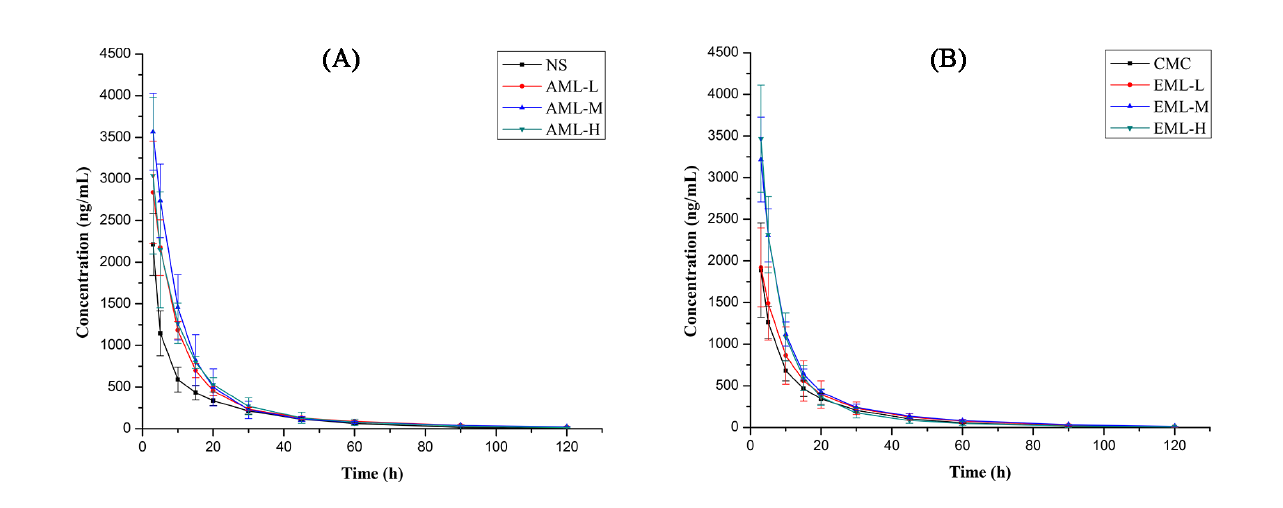
FIGURE 3 – Mean plasma concentration-time profiles of phenacetin in rats pre-treated with AML (A) and EML